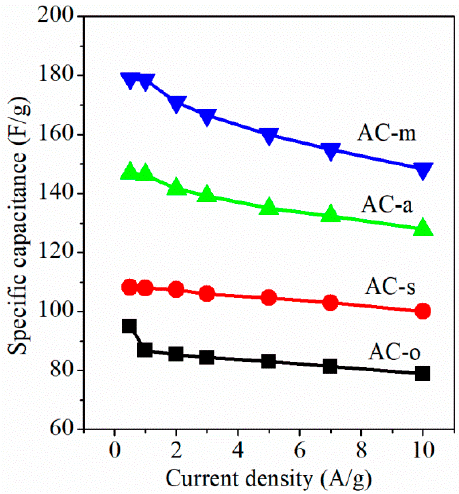
Figure 6. Specific capacitance as a function of applied current load.